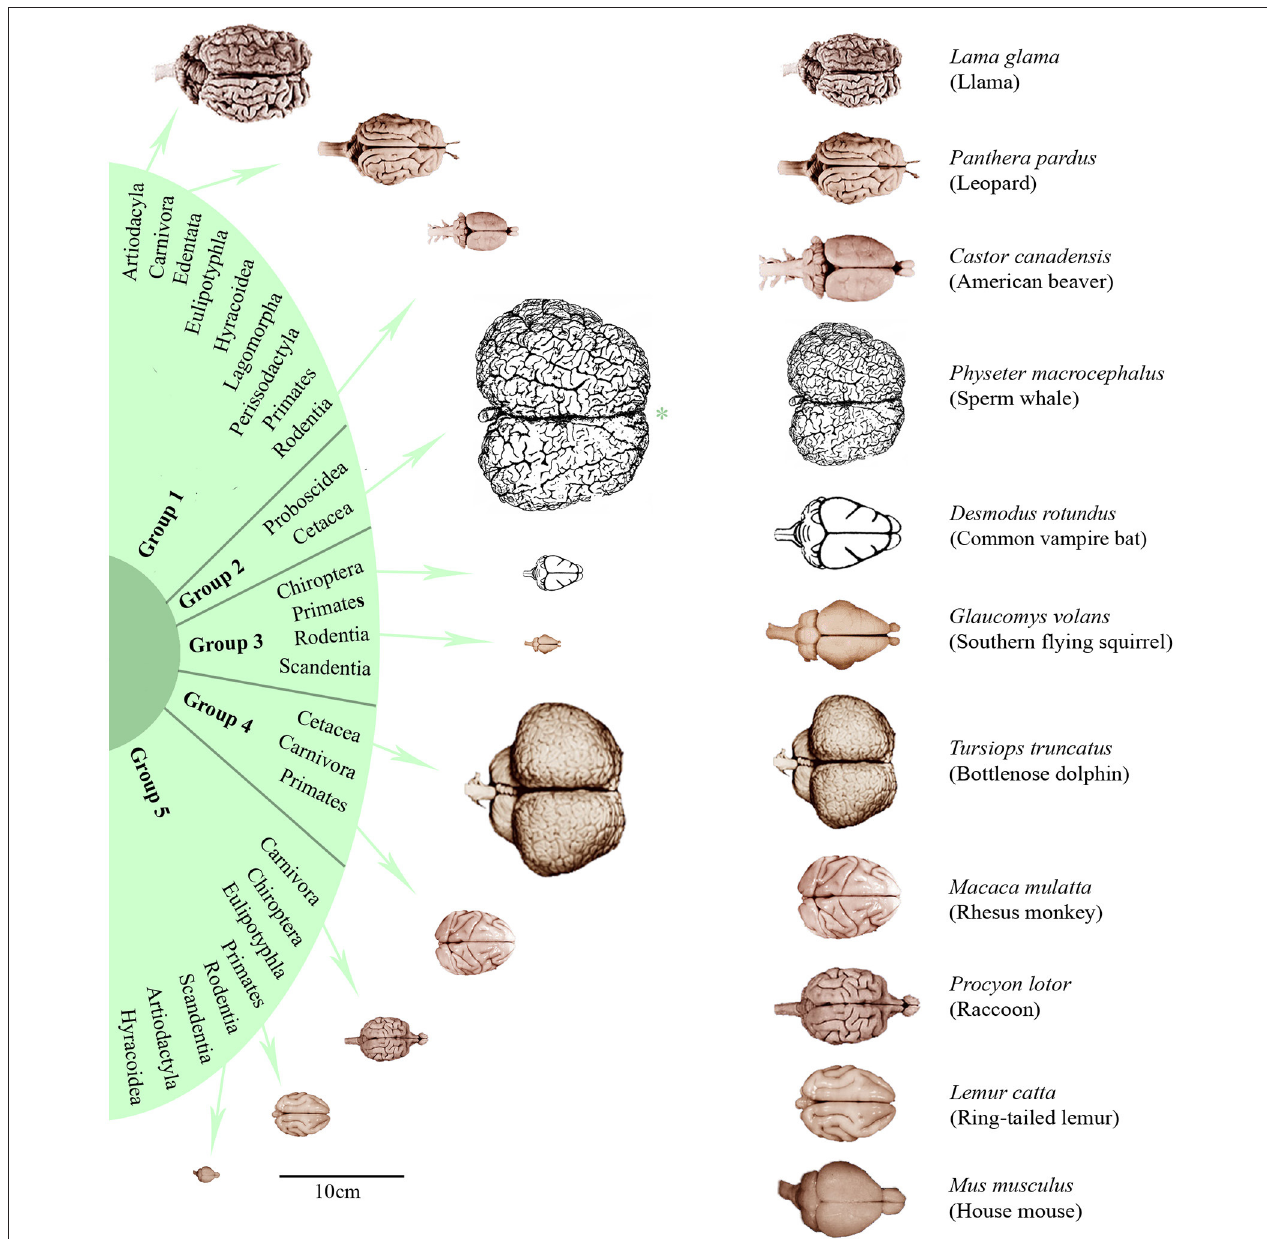
FIGURE 3 | Dorsal brain views of representative eutherian species arranged according to the dendrogram shown in Figure 1. On the left, the brains were aligned in scale (*except the sperm whale brain which is only half of its scale) and, on the right, scaled to the same total length. Brain photographs were taken from the University of Wisconsin and Michigan State Comparative Mammalian Brain Collections (www.brainmuseum.org), the sperm whale brain was depicted after Kozima (1951) and the common vampire bat brain after Baron et al. (1996).